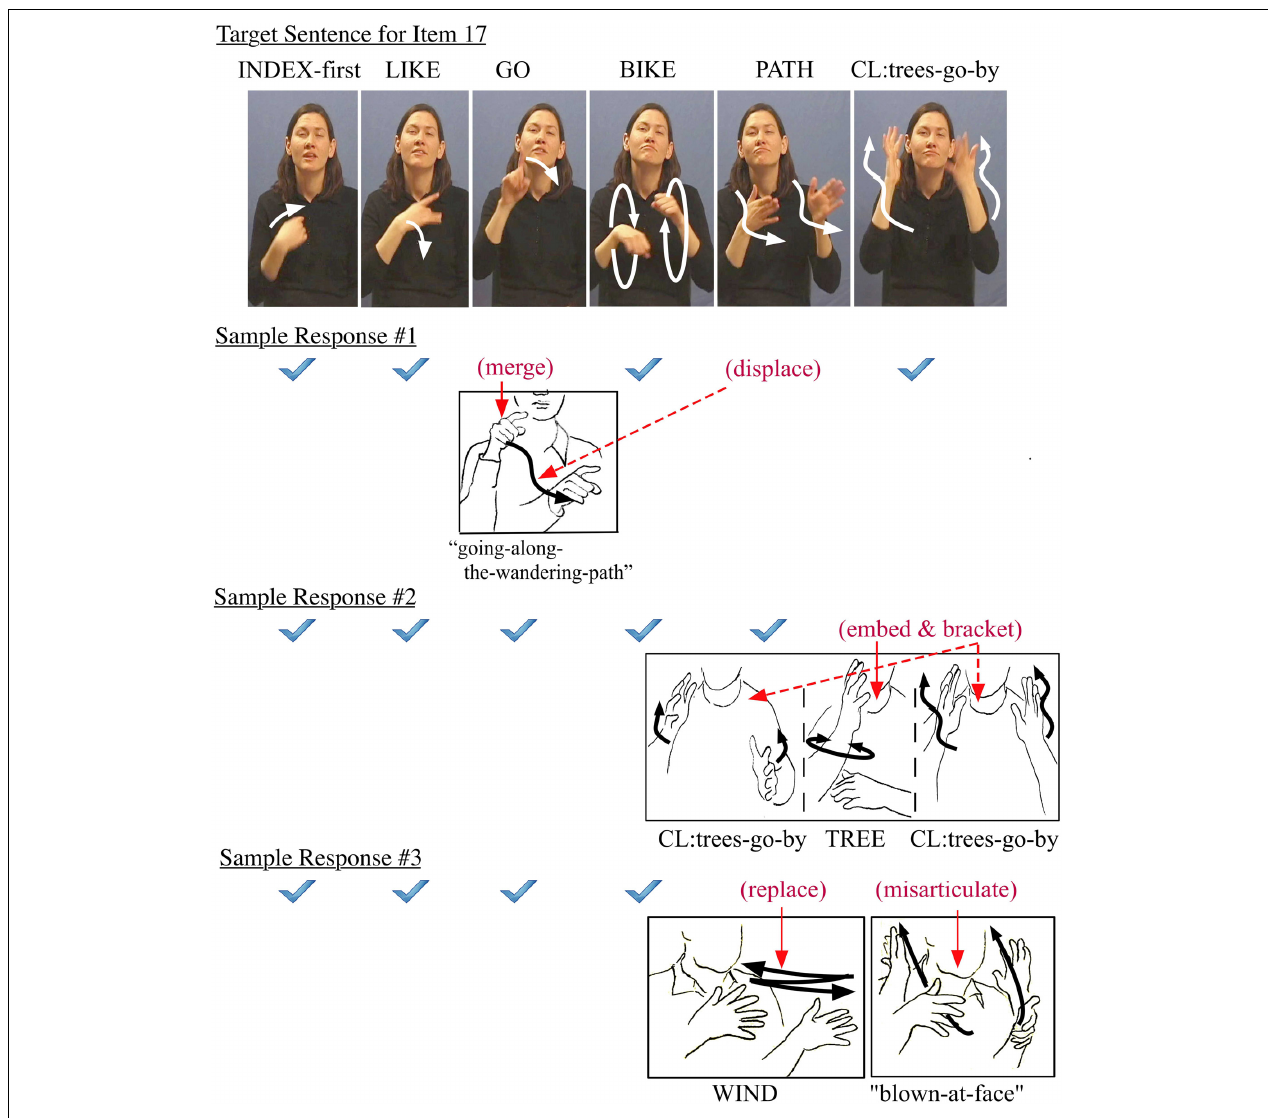
FIGURE 8 | Sample errors in responses to Item